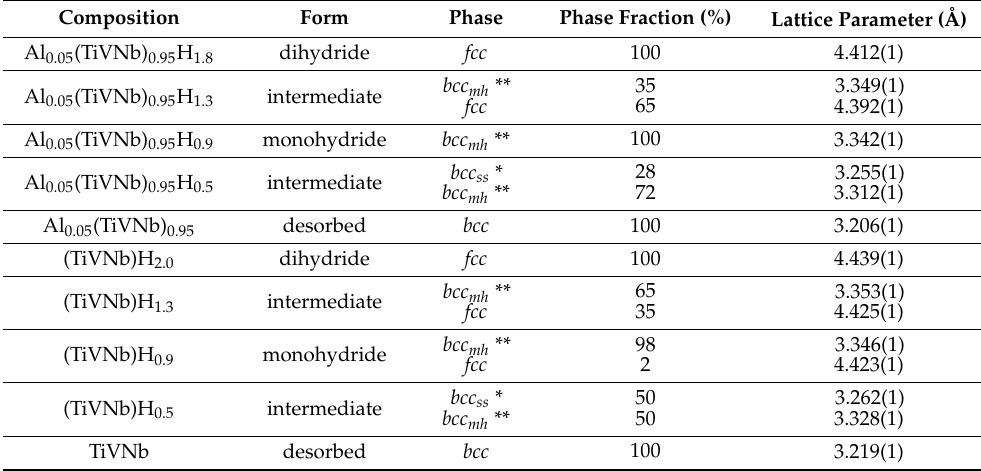
Figure 5. Ex situ SR-XRD patterns ( λ = 0.72907 Å) at several stages of the hydrogenation process for ( a ) Al 0.05 (TiVNb) 0.95 and ( b ) TiVNb. Table 5. Lattice parameters of the Al 0.05 (TiVNb) 0.95 and TiVNb alloys as dihydride (1.8 and 2.0 H/M), partially hydrogenated (0.5 and 1.3 H/M), monohydride (0.9 H/M), and desorbed phases.